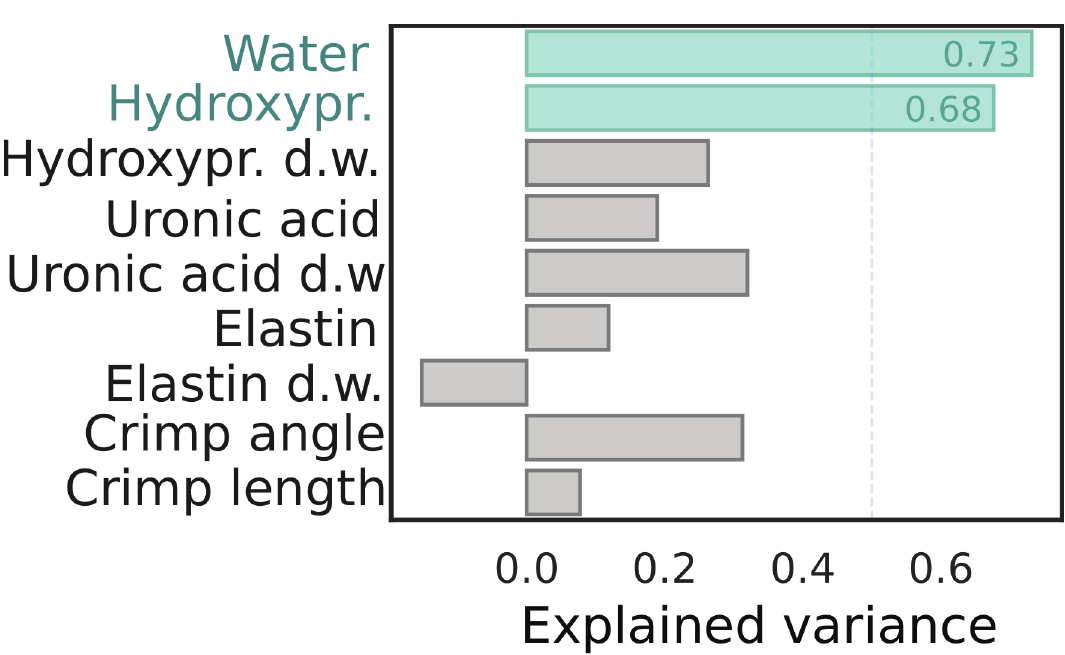
Fig 5. Accuracy of the predictive models. Median prediction performance (in terms of explained variance) for nine different biochemical and structural properties. Median performance was computed using a 10-fold repeated (N = 10) cross-validation. Only the prediction for water and hydroxyproline content (of wet weight) produced models with over 50% of the variance explained.